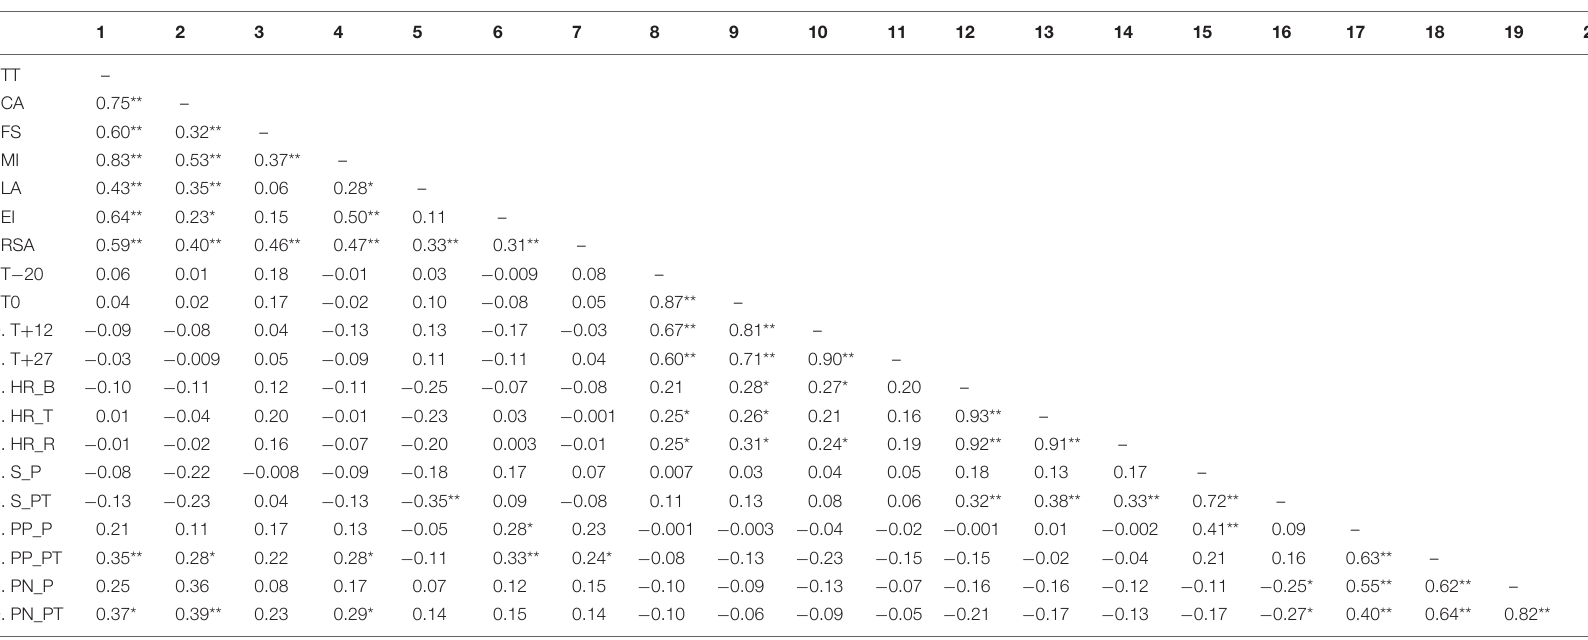
TABLE 4 | Pearson coefficients for associations between Transport Narrative questionnaire and respective subscales, Rate Arousal Sexual, Cortisol, Heart Rate, State Anxiety, and Positive and Negative Affect (df =